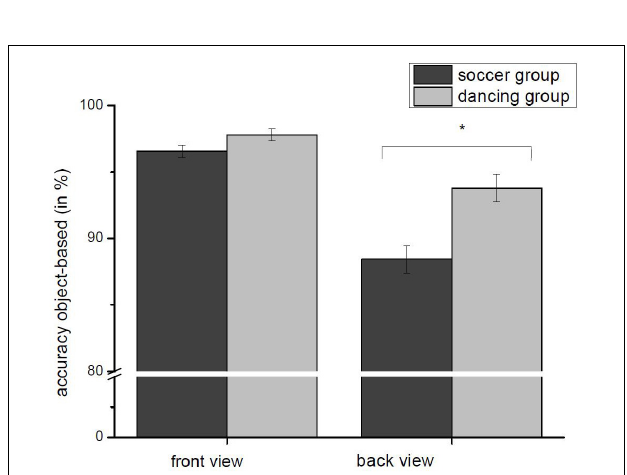
FIGURE 4 | Accuracy (Mean and SE) dependent on group and view for the object-based transformation. Dancers show a significantly higher accuracy rate for back view stimuli compared to soccer-players for object-based transformation. ∗ Indicates a significant difference between both